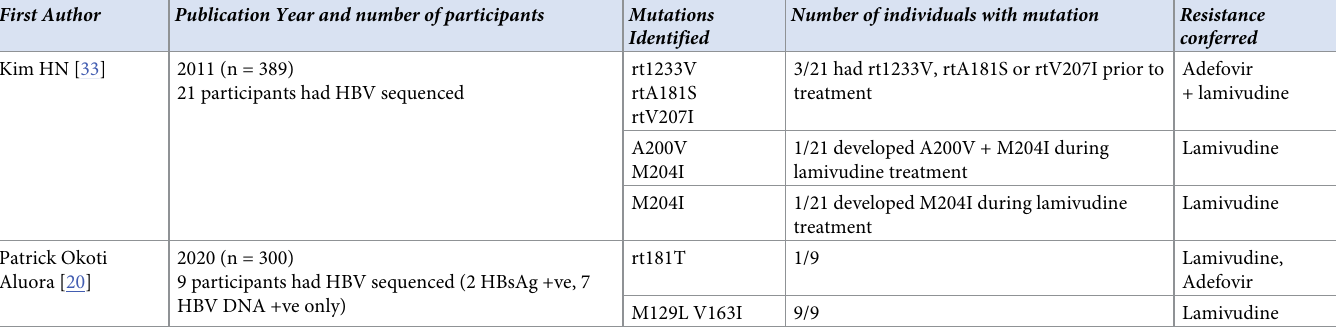
Table 4. Details of HBV mutations found in two studies in Kenya which reported presence of drug resistance mutations, as part of a systematic review on preva- lence and genetic data for HBV in Kenya from